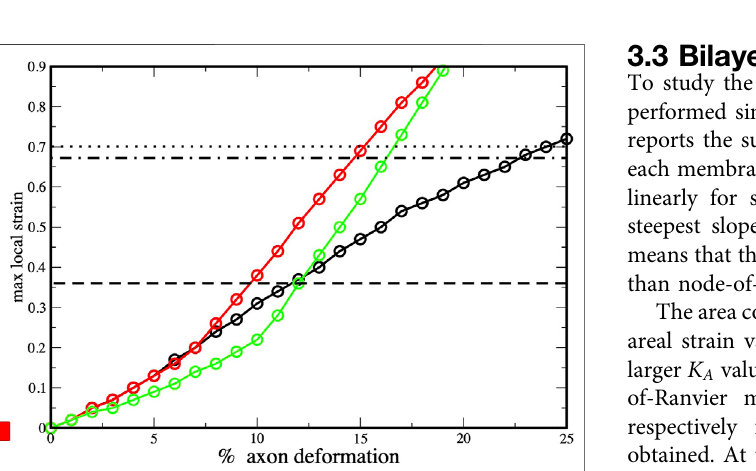
FIGURE 4 | Node-of-Ranvier (A) and myelin (B) bilayers at 0.36 and 0.70 strain, respectively. For color code see Figure 2 .